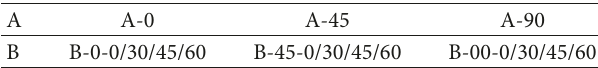
Table 2: Samples used in the